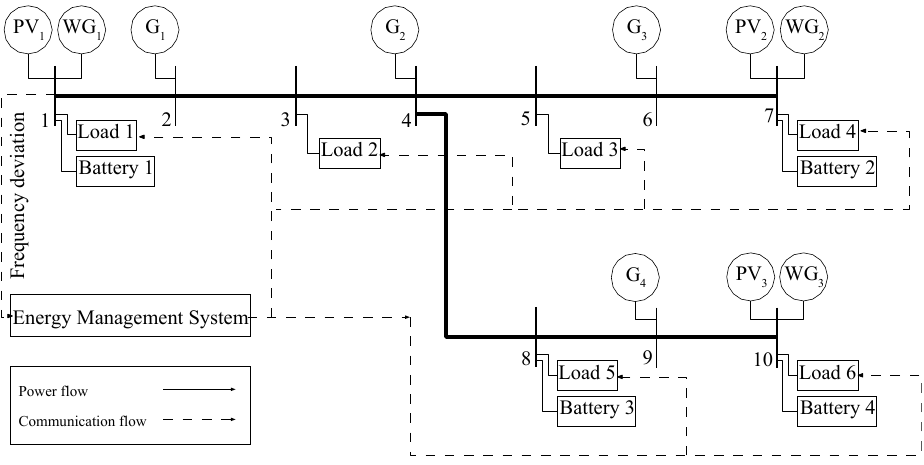
Figure 1. Power system